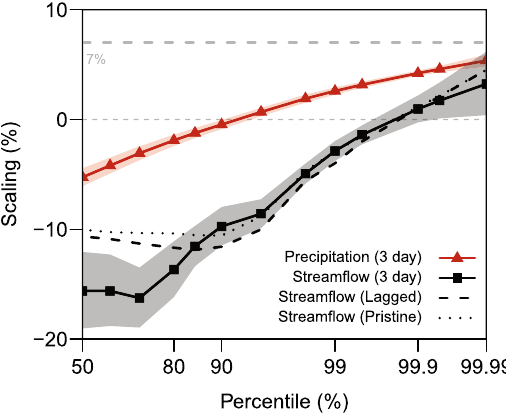
Figure 4. Sensitivity testing of streamflow scaling. Precipitation and streamflow scaling for three day accumulations is presented. Streamflow scaling is also presented using only pristine catchments and matched to the temperature corresponding to the streamflow inducing precipitation event, termed lagged. All streamflow scaling is presented in black, with precipitation scaling in red. Shading represents 90% confidence limits for the three day accumulation. Scaling is calculated using linear regression on the calculated percentiles as presented in Fig. 2. As a reference, the thick grey dashed line represents the approximate Clausius-Clapeyron scaling of 7%. Figure was created using the statistical software ‘R’ 61